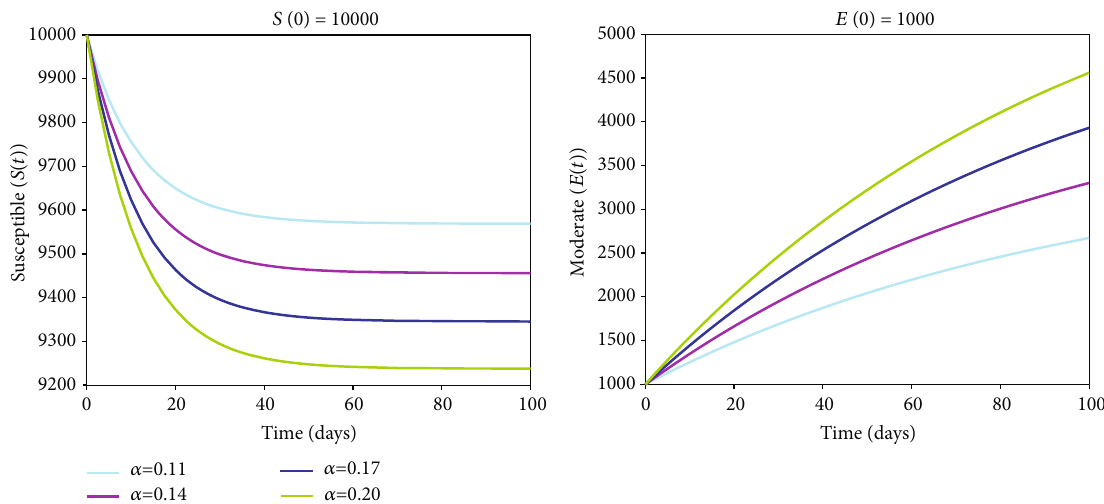
Figure 5: Moderate khat chewer and addicted population with varying rate at which E ð t Þ joins to I ð t Þ and R ð t Þ , β